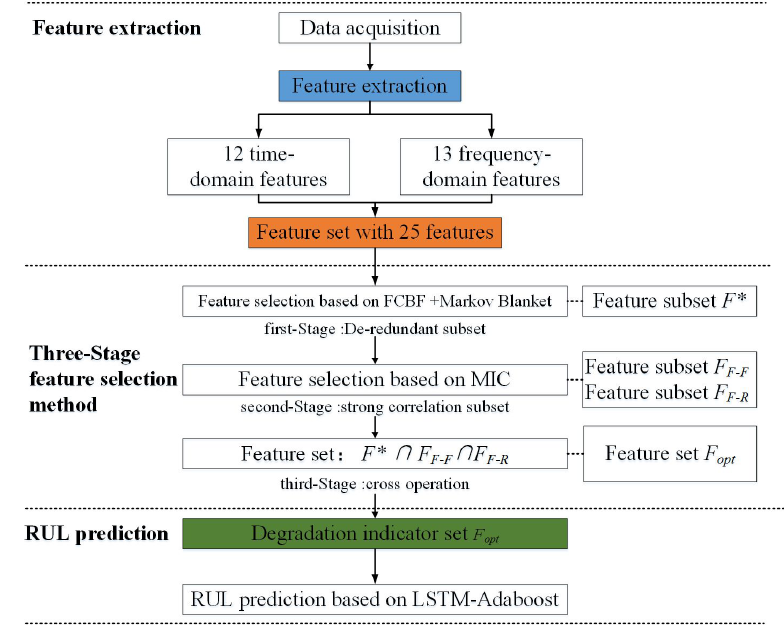
Figure 3. A flowchart of the proposed bearing degradation indicator